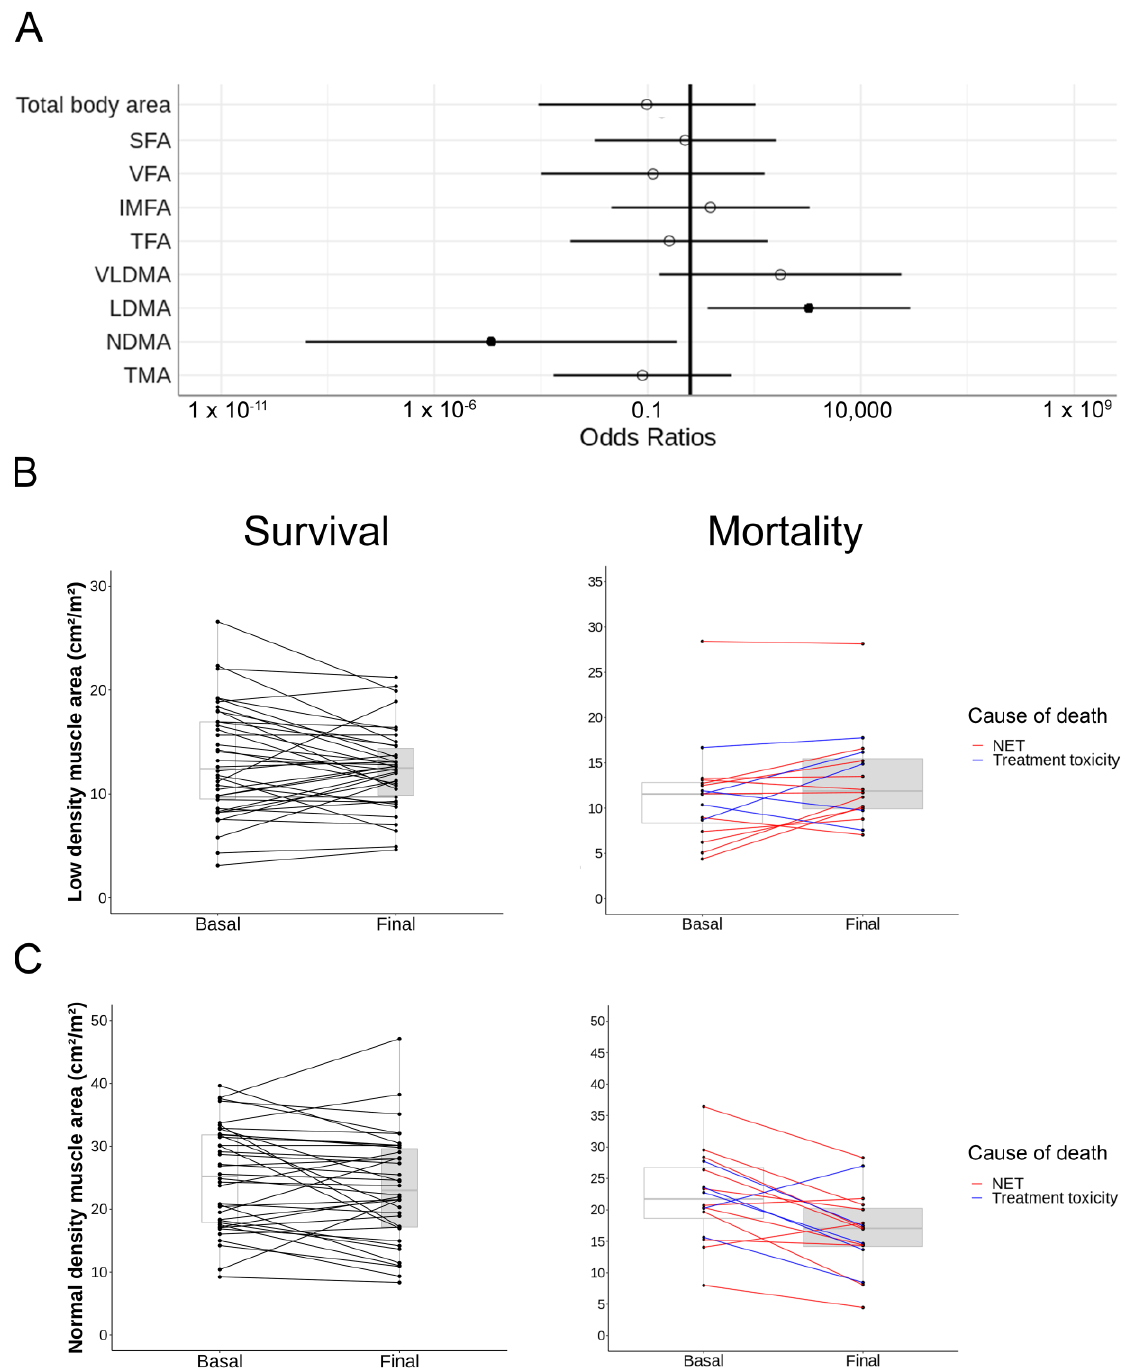
Figure 4. Changes in body composition and their relationships with mortality. ( A ) Odds ratio of body composition measures and relationship with overall mortality. Filled circles represent significant protective (left) and risk factors (right) of overall mortality in this cohort, whereas unfilled figures indicate non-significant values. Vertical black line highlights odd ratio = 1. Confounding factors in the model: age, metastases, ECOG (Eastern Cooperative Oncology Group performance status), lactate dehydrogenase (LDH), albumin and urea. SFA, subcutaneous fat area; VFA, visceral fat area; IMFA, intermuscular fat area; TFA, total fat area; VLDMA, very low-density muscle area; LD, low-density muscle area; NDMA, normal-density muscle area; TMA, total muscle area. ( B ) Change in low-density muscle and ( C ) normal-density muscle areas in survival (left) and mortality (right). Black lines correspond to survival patients, red lines to tumor-related mortality and blue ones to treatment-toxicity-related